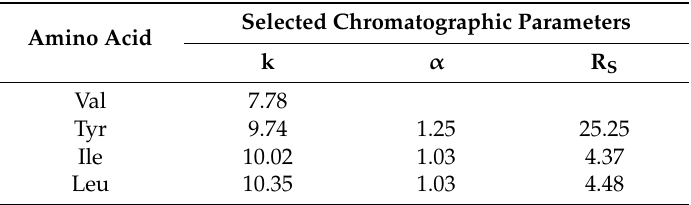
Table 3. Selected chromatographic parameters (retention factor k, separation factor α and resolution factor R S values) obtained in the analysis of the investigated amino acids according to their elution order.